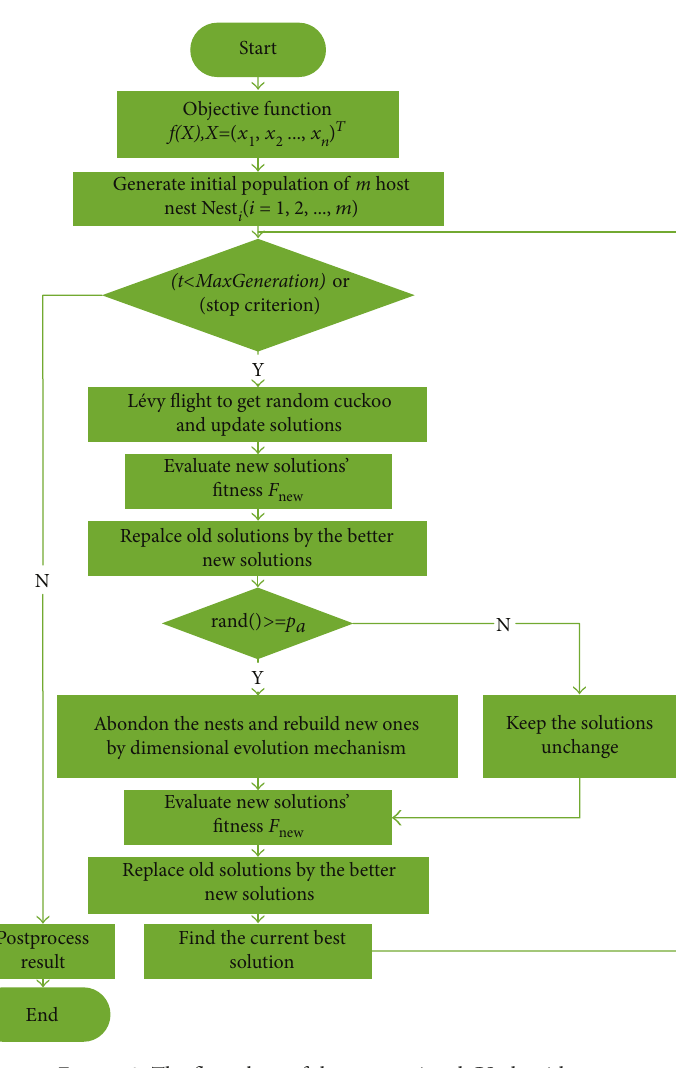
Figure 2: The fl ow chart of the conventional CS algorithm.